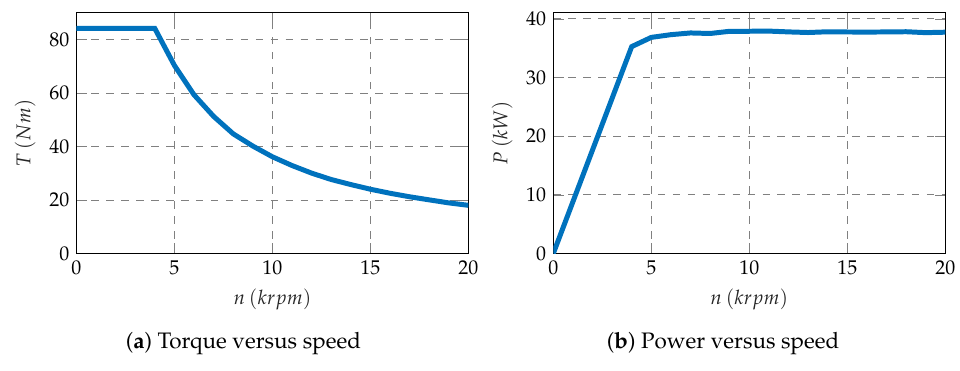
Figure 9. Torque and Power of PRC-6